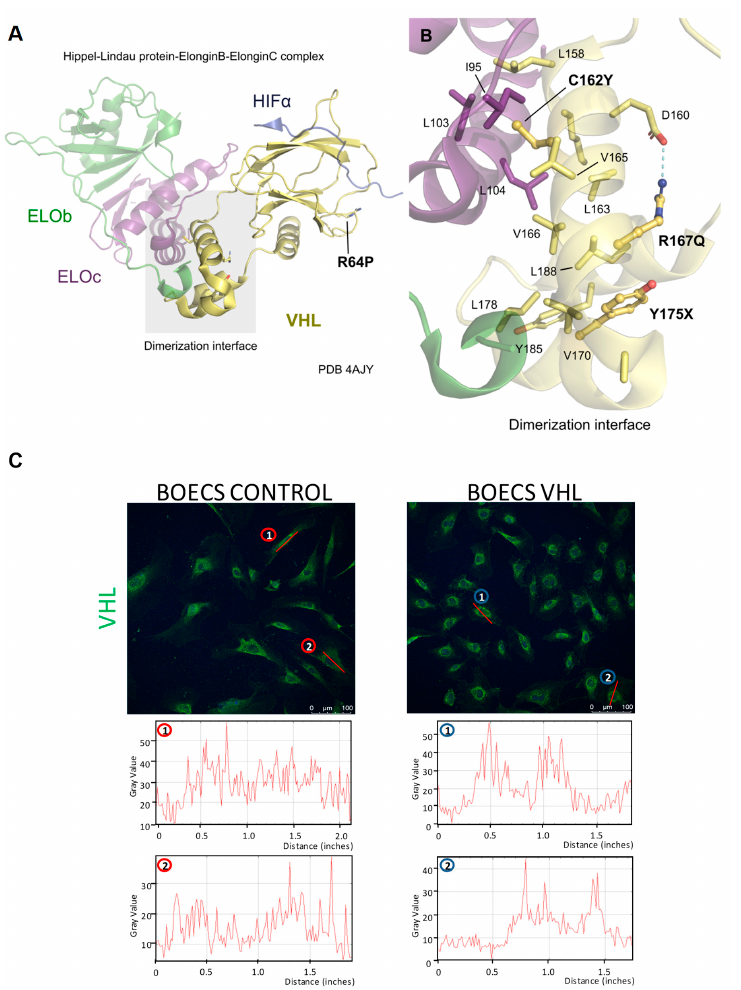
Figure 8. ( A ) 3D complex structure (PDB ID: 4AJY) of the von Hippel–Lindau protein (yellow), Elongin B (green), and Elongin C (purple), bound to Hif1- alpha peptide (depicted in dark blue), highlighting the heterodimerization interface of this complex in a gray box and the position of the R64P mutation. ( B ) Inset of the VHL-ELOb/c interface with their respective involved amino acids are represented as sticks, while the relevant mutation positions are represented with spheres and labelled in bold. ( C ) Confocal staining of sample V1 (p.R167Q) shows the distribution of pVHL in the cell cytoplasm, distributed in the perinuclear region in VHL cells and throughout the cell in control ones.